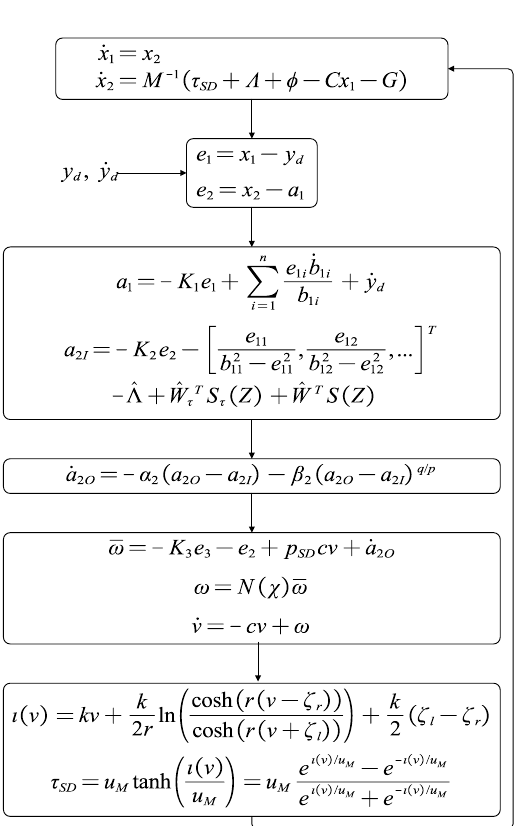
Figure 7. The control process of the adaptive neural network